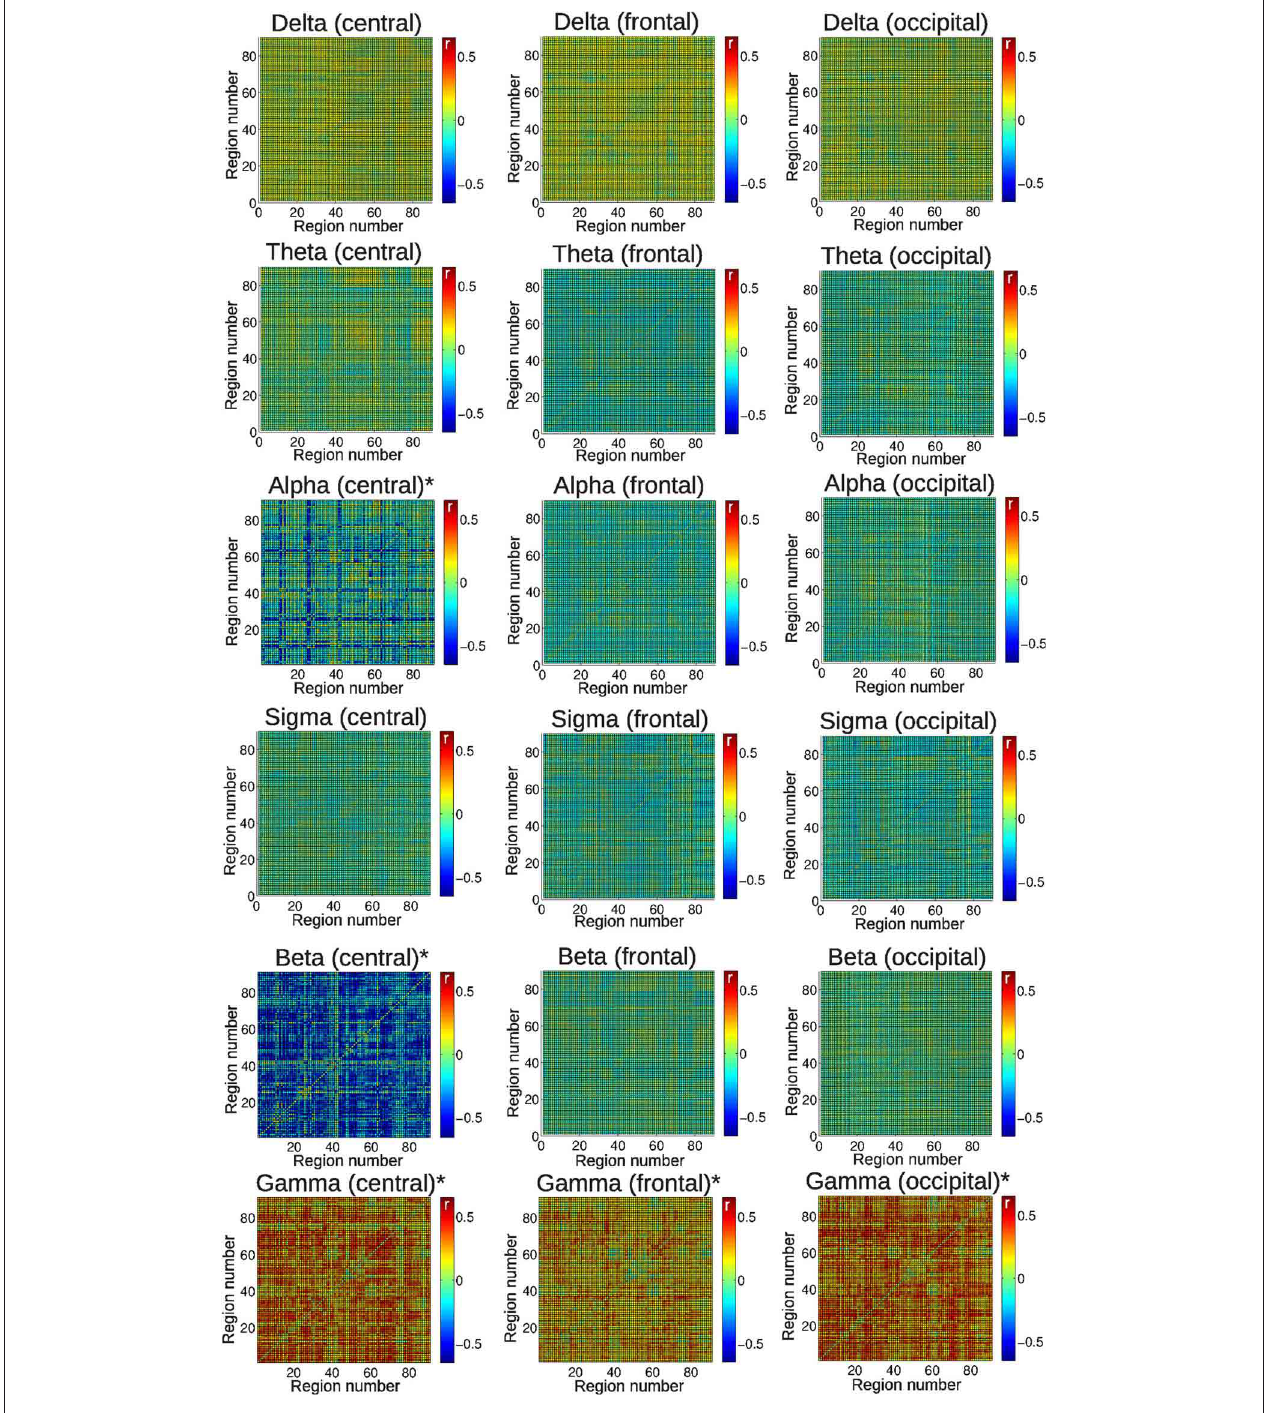
∗ indicates the frequency bands and scalp regions for which significant correlations were found (see Figure 4 ). For the AAL regions associated with region numbers, see Table 1